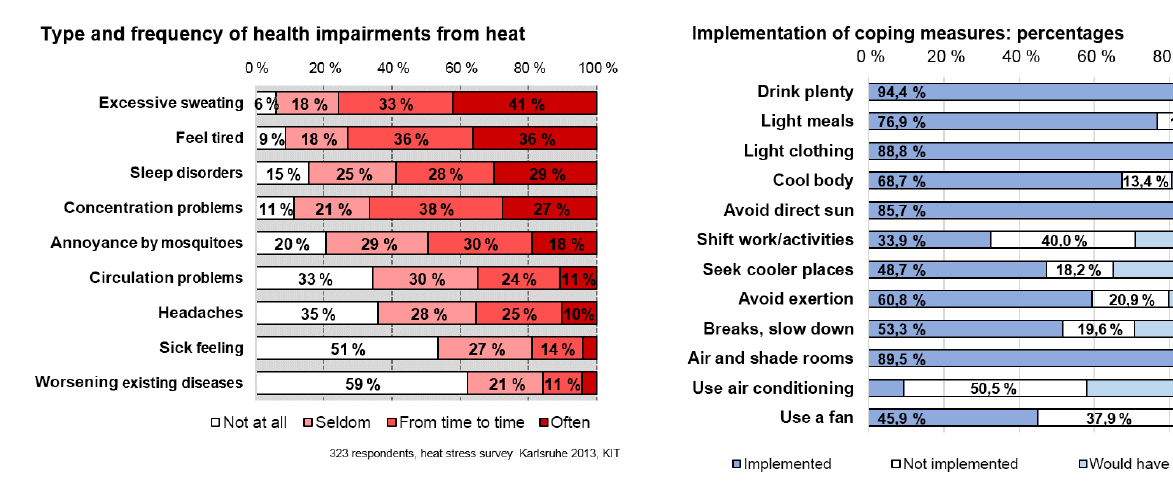
Figure 5. Type and frequency of health impairments from heat re- ported by respondents. Exact numbers for percentages below 5% are not indicated in the figure.